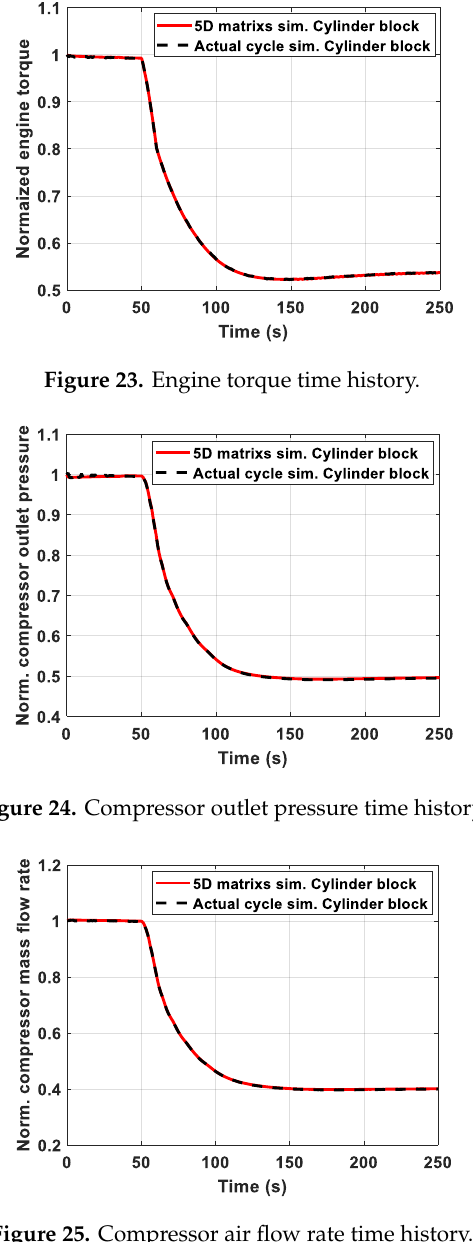
Figure 26. Turbine inlet pressure time history. Figure 27. Turbine inlet temperature time history.